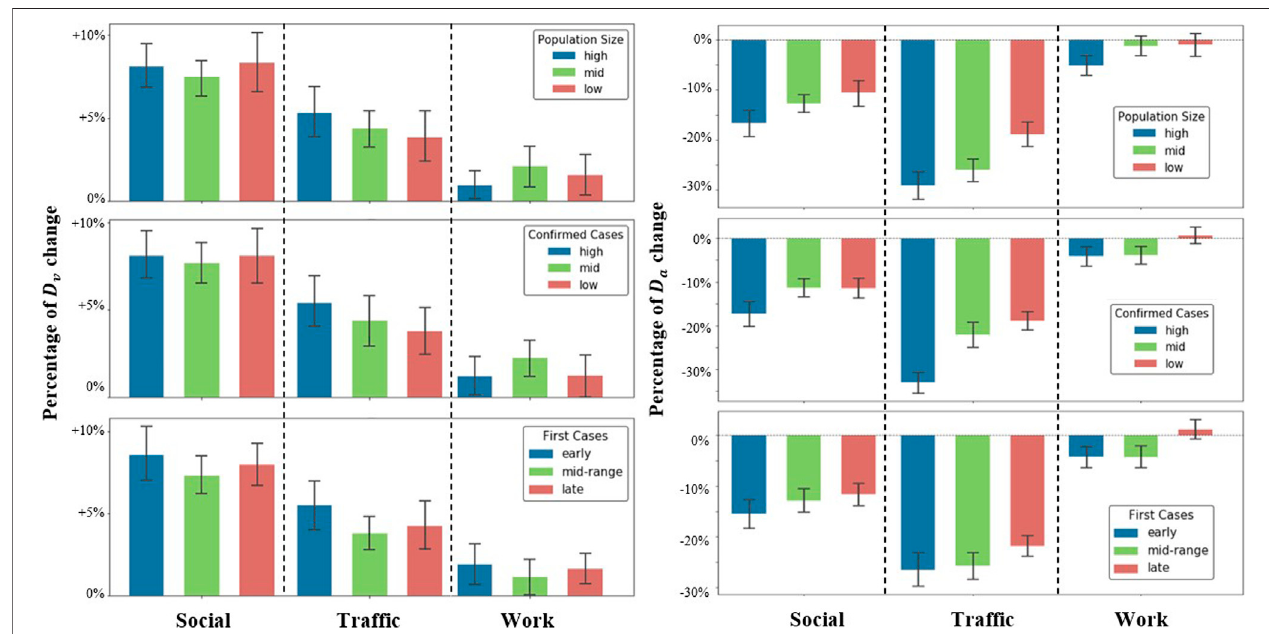
FIGURE 8 | Change in Venables distances ( D v ) and activity density ( D a ) across counties with different population sizes, con fi rmed cases number, and the date of fi rst con fi rmed case in the three tile activity categories (social, traf fi c, and work).